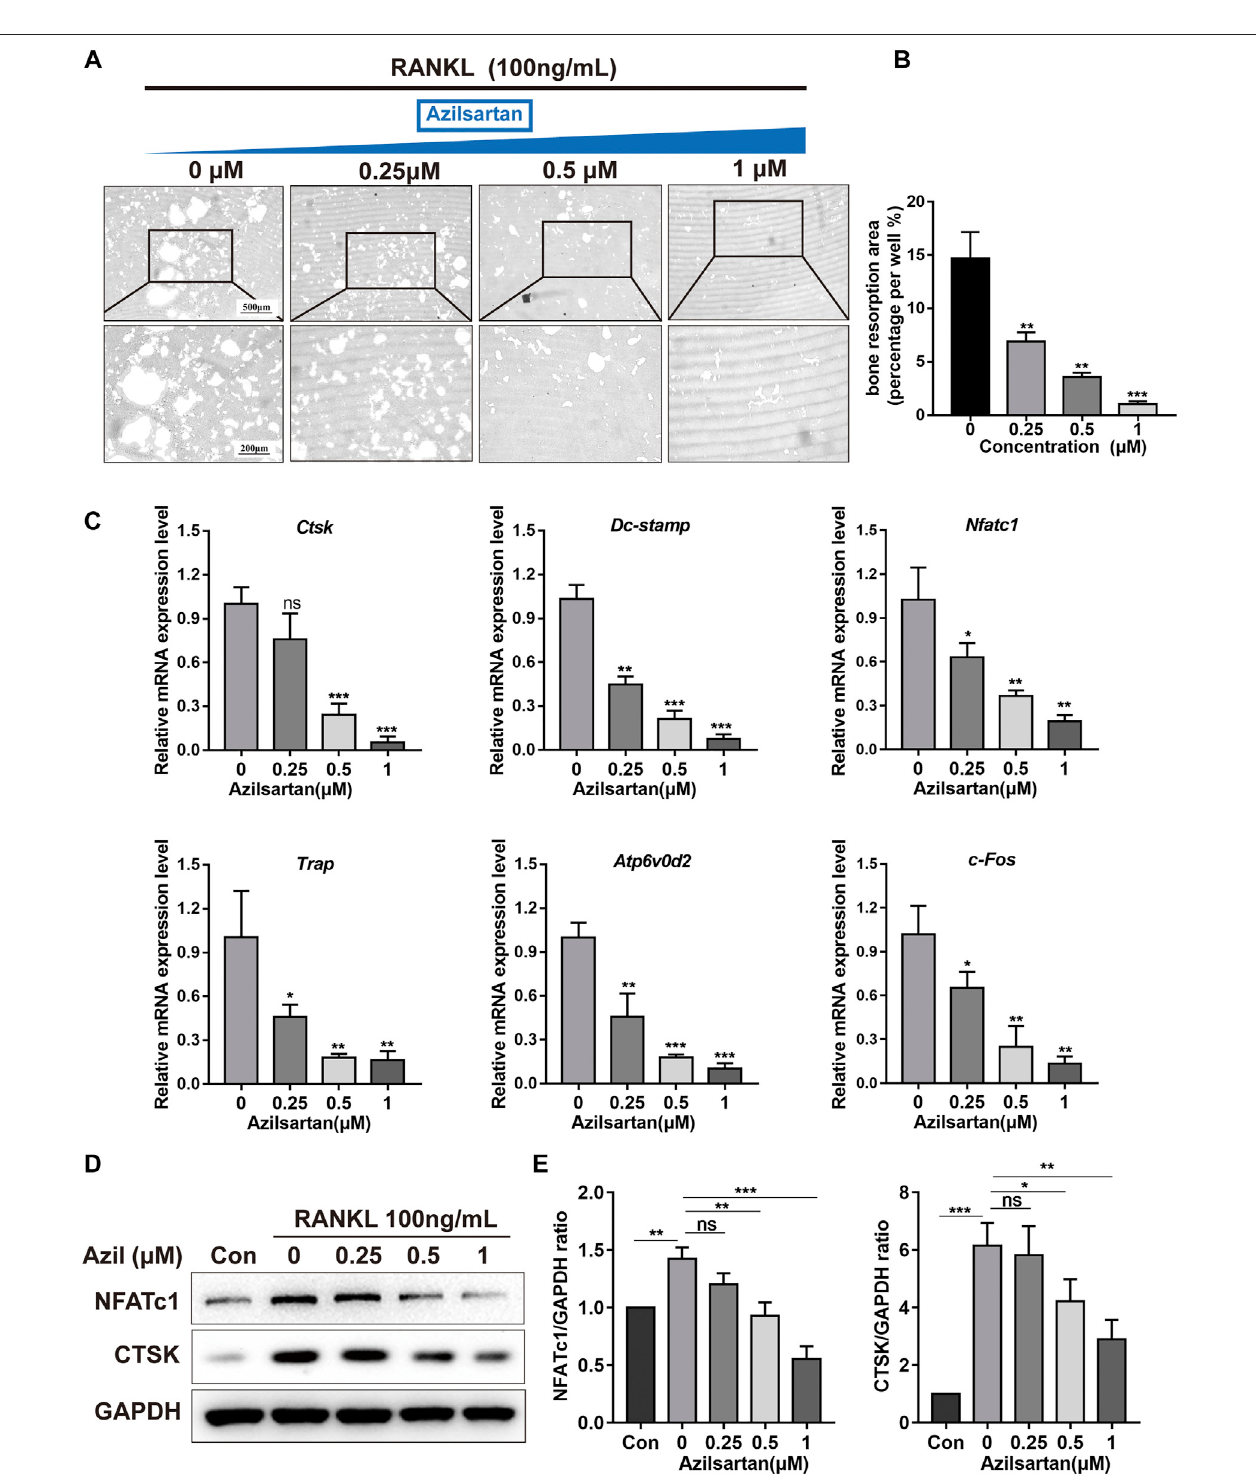
FIGURE 2 | Azilsartan inhibits osteoclast resorption function and affects osteoclast-speci fi c genes expression. (A) Representative images of osteoclast bone resorption on the hydroxyapatite surface; BMMs were treated with RANKL (100 ng/ml) for 3 days until small mature osteoclasts formed. Then, osteoclasts were reseededandculturedwithdifferentconcentrationsofAzilsartanforanother3 daysinhydroxyapatite-coatedplates. (B) Quantitativeanalysisoftheboneresorptionarea per well using the ImageJ software( n (cid:2) 3). (C) The speci fi c-genes expression of Nfatc1 , Ctsk , Trap , c-Fos , Atp6v0d2 , and Dc-stamp were determined by qPCR; BMMs were stimulated with RANKL and different concentrations of Azilsartan (0, 0.25, 0.5, and 1 μ M) for 5 days ( n (cid:2) 3). Untreated cells were used as a control. (D)